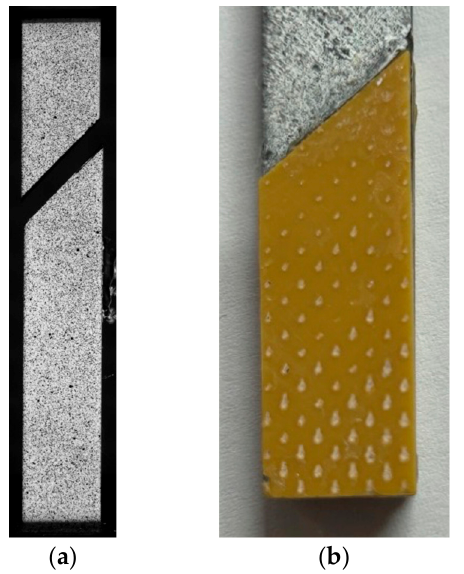
Figure 5. Representative fractured 45° off-axis tension specimen: ( a ) Failure mode of a 45° off-axis tension specimen; ( b ) End-tab region of the specimen.